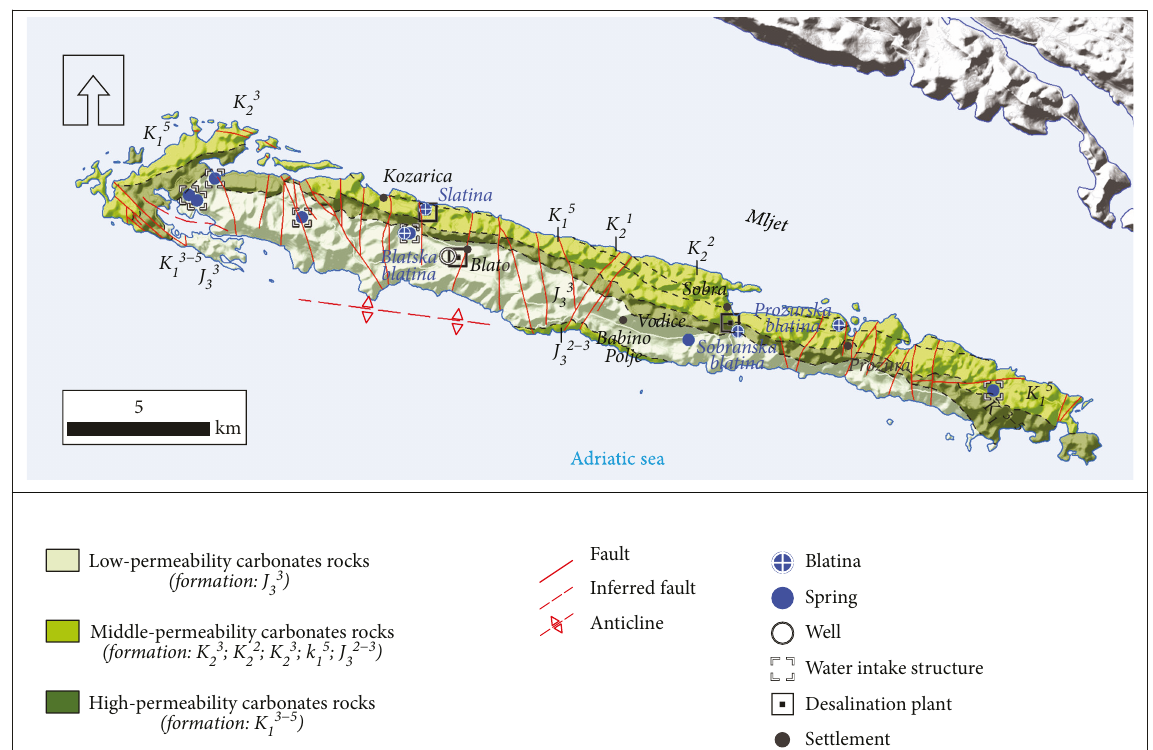
Figure 3: Hydrogeological map of the island of Mljet (modi fi ed after [19,